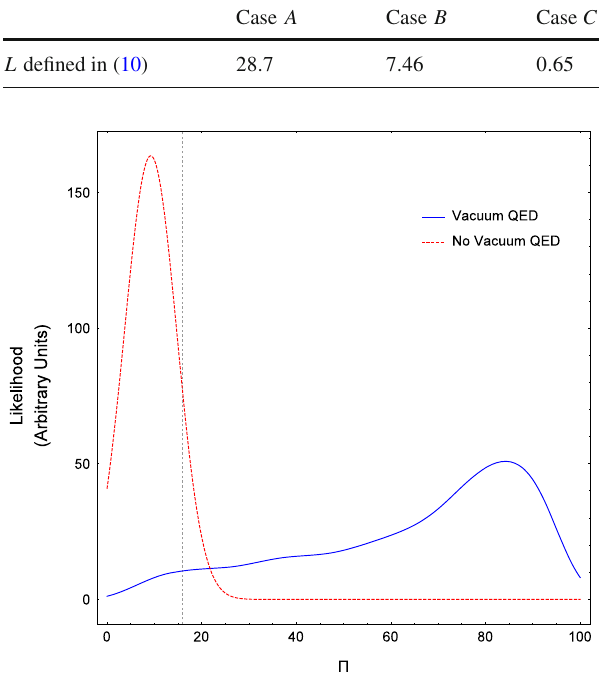
Fig. 3 The likelihood of the polarization degree in both hypotheses including the integration over the unknown angles χ and ξ . Prior proba- bilitiesofcase B havebeenused.Theverticaldashedlineistheobserved value. In order for experimental data to favor the existence of vacuum birefringence, values of the polarization degree larger than ≈ 30% must be